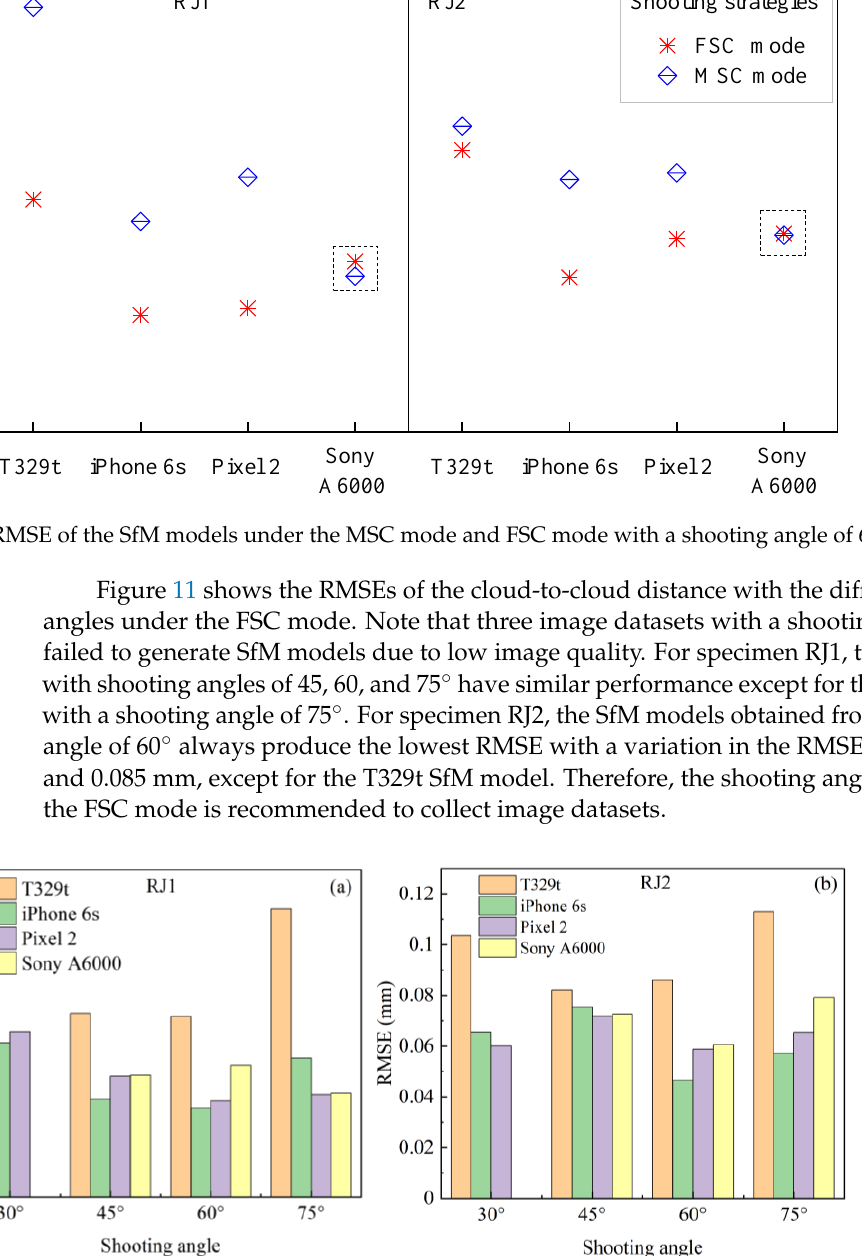
Figure 11. Comparison of the RMSE of the SfM models with the different shooting angles under the FSC mode, ( a ) specimen RJ1, ( b ) specimen RJ2.